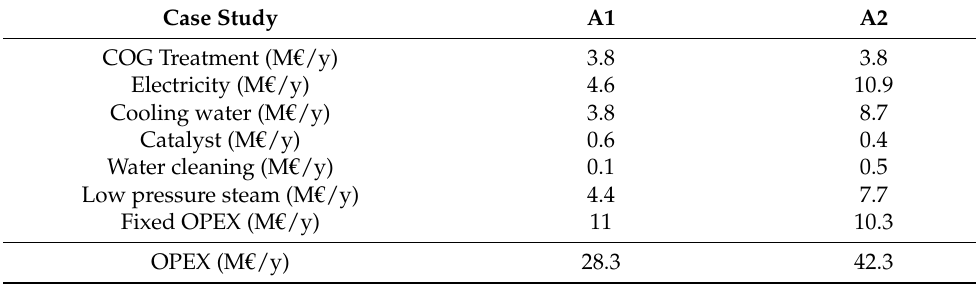
Table 9. Distribution of OPEX by type of utility used for case studies A1 and